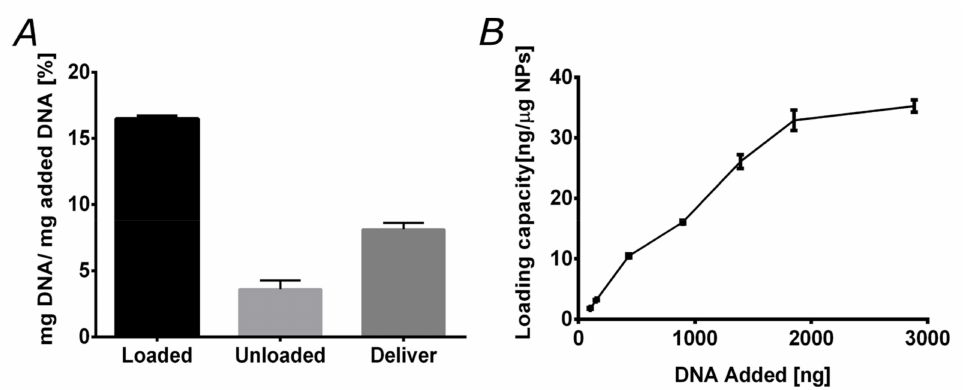
Figure 5. Nanoconjugate loading and delivering capacities. ( A ) Loading and delivery capacities of the magnetite / silver-pDMAEMA nanoconjugates. The loading capacity approaches 16%, while instant delivery capacity is around 8%. ( B ) magnetite / silver-pDMAEMA-PEA-BUFII loading capacity (defined as the ng of DNA loaded per µ g of the nanoconjugate) exhibits an initial linear regime for DNA amounts up to 2000 ng followed by saturation above 3000